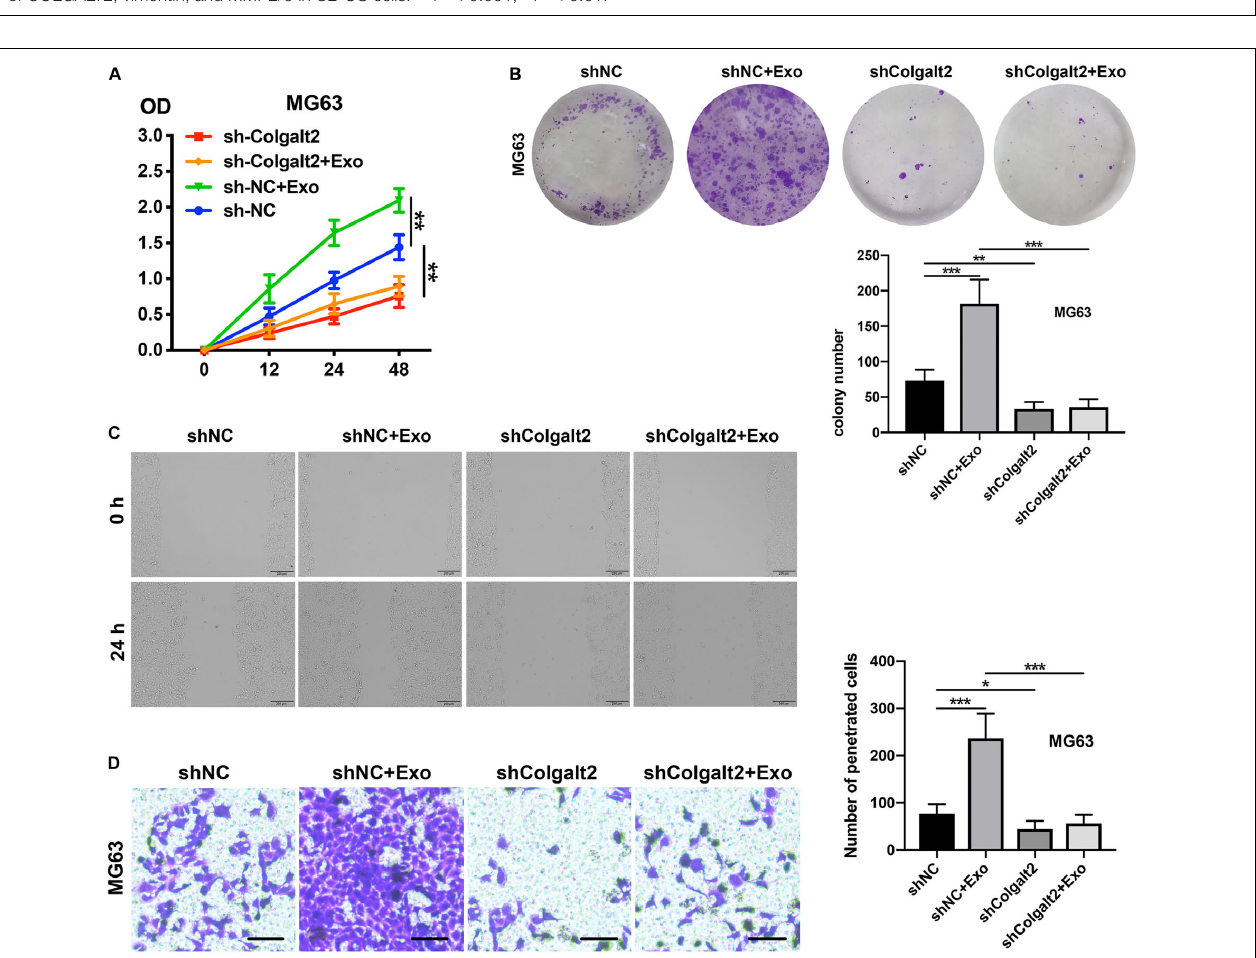
FIGURE 5 | COLGALT2 inhibition attenuates the osteosarcoma-promoting effects of ADSC exosomes. (A) The effects of COLGALT2 inhibition on MG63 cell proliferation were assessed with a CCK8 assay. Data collected from the three respective experiments are reflected. (B) Representative images of colony numbers (right panel) and colony formation (left panel) after COLGALT2 knockdown in MG63 cells. (C) Representative images of wound areas at 24 h after COLGALT2 knockdown in MG63 cells. MG63 cells that were cultured alone served as controls. (D) Representative images and statistical analysis of invaded cells in the Transwell invasion assay. All values are presented as the means ± SDs of three independent experiments. *** P < 0.001, ** P < 0.01, * P < 0.05.